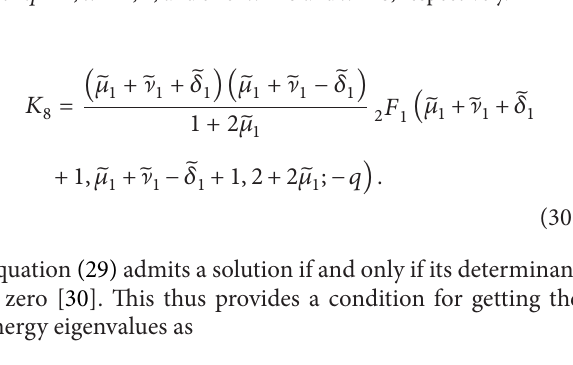
Figure 1: The plot of the qHPT potential as a function of position with 𝑞 = 1 , 𝛼 = 1 , 2, and 3 for 𝑥 < 0 and 𝑥 > 0,